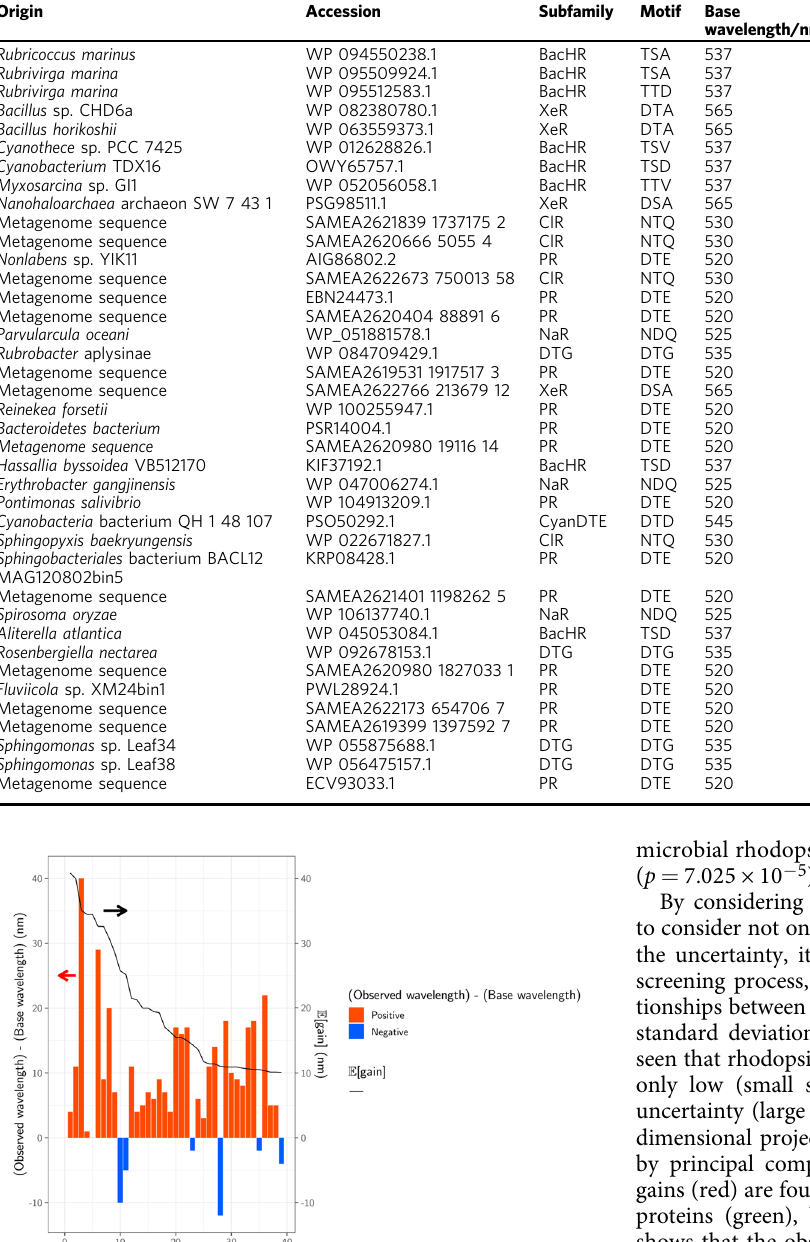
Table 1 Predicted and observed gains of 39 microbial rhodopsins expressed in E. coli .